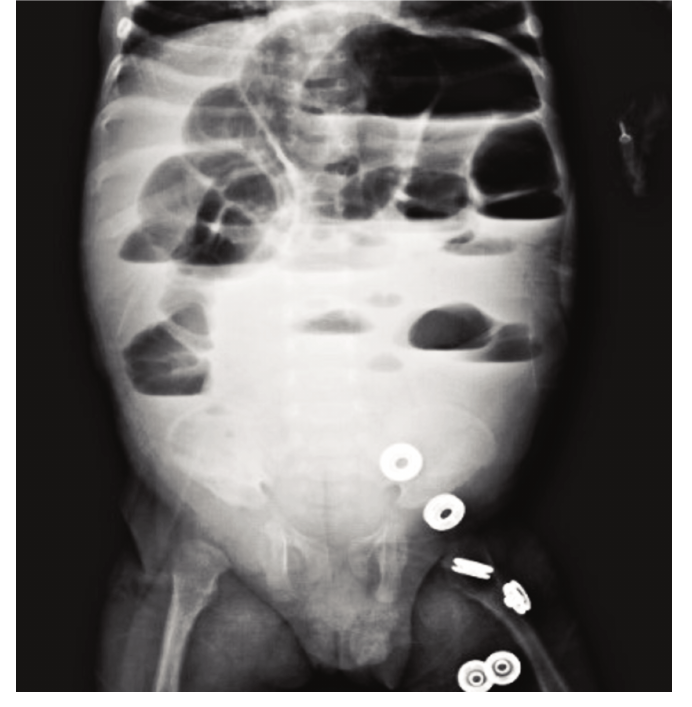
Figure 1. Multiple air fluid levels seen in distended small intestine, but no pneumoperi-